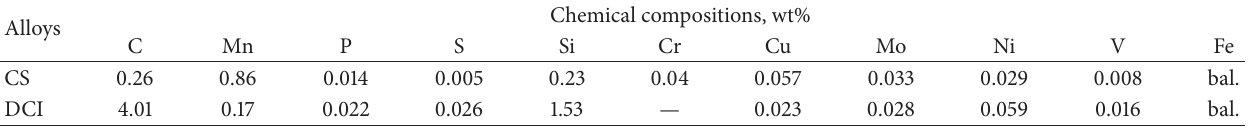
Table 1: Chemical compositions of experimental